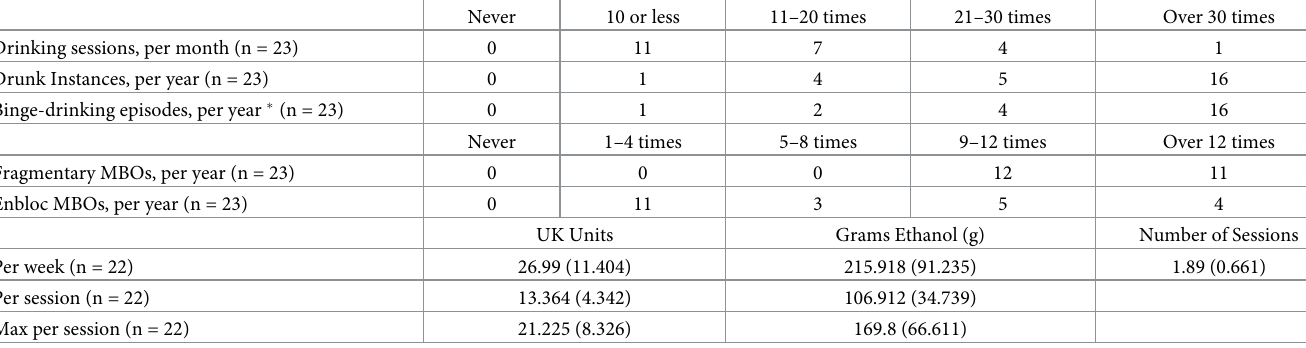
Table 3. Self-reported frequency of drinking behaviours of MBO